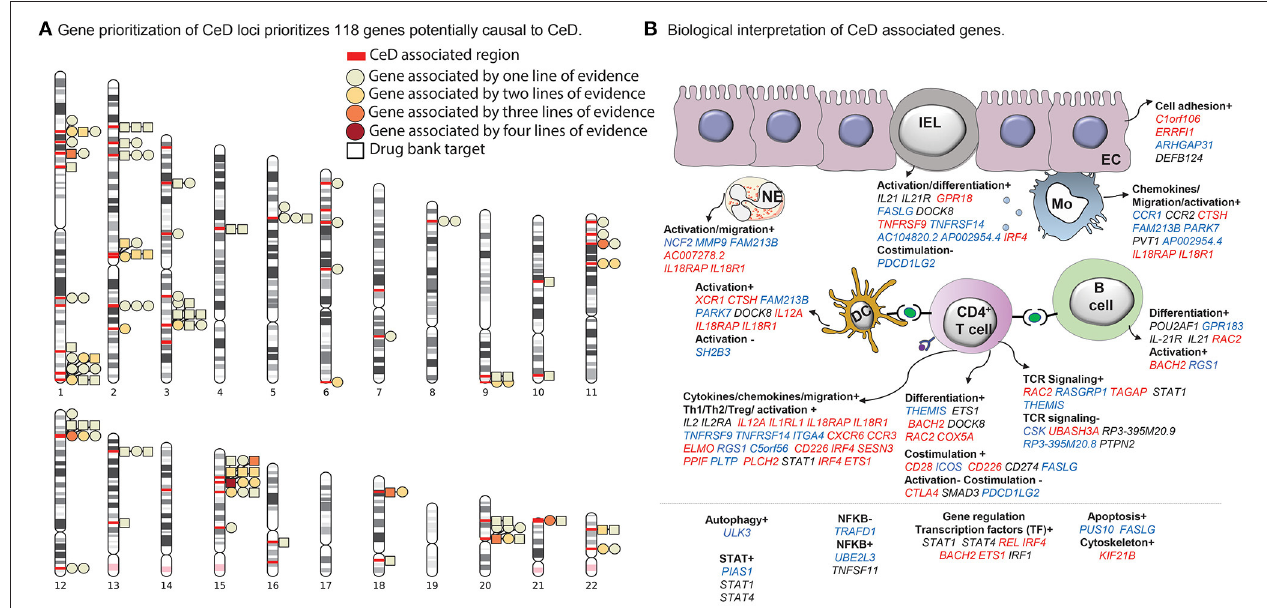
FIGURE 1 | Celiac disease (CeD) prioritized genes and their proposed function and cell type. (A) A chromosome ideogram depicting the location of each prioritized gene identified in a CeD-associated genome-wide association study (GWAS) locus. Loci are marked with red bars. Genes depicted by a square are the target of an approved drug or a drug in development. All other genes are depicted by a circle. Each circle or square is colored according to the lines of evidence (see Methods) supporting its causal role. (B) Functions and cell types highlighted by the prioritized genes, according to our literature review (see Methods) ( n = 118 genes; for 37 genes, neither a function nor a specific cell type on which the gene may operate could be specified). All genes contributing to a specific function are listed under the subheading and colored according to the change that leads to increased CeD risk: increased expression (red), decreased expression (blue), or undefined (black). The symbols + or – denote if a biological process is thought to be induced or repressed by the gene, respectively, according to